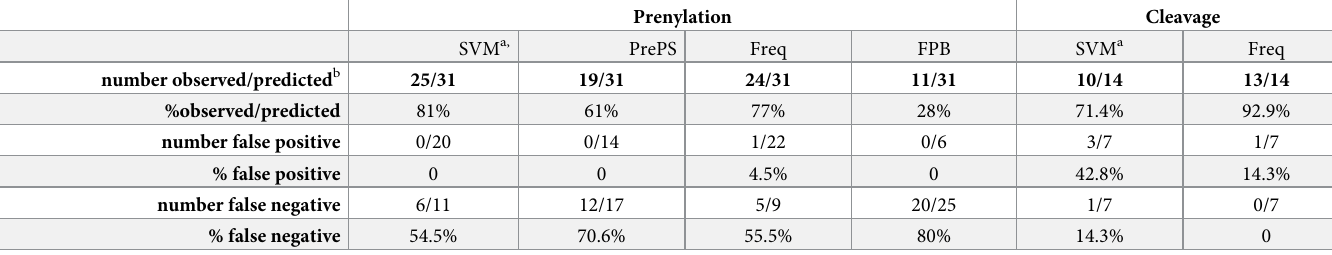
Table 5. Summary of prenylation and cleavage